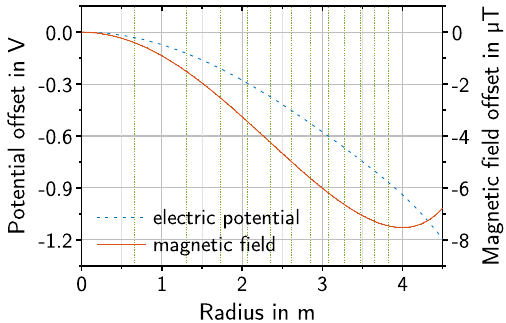
Fig. 9 The calculated radial inhomogeneity of the electrostatic poten- tial and the magnetic field in the analyzing plane of the main spectrome- ter, for the standard setting of U = − 18 , 600 V and B A = 0 . 3 mT. The plot shows the offset in the potential and the magnetic field values in the spectrometer center. The vertical dashed lines mark the corresponding outer radii of annuli mapped to the 13 detector